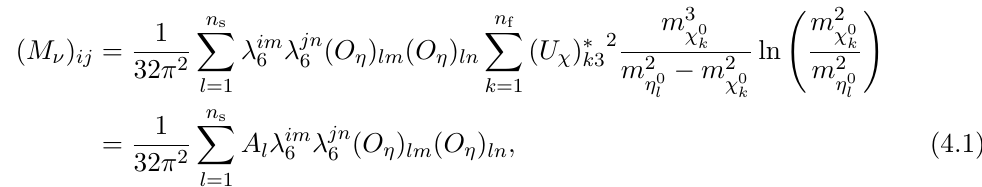
1 ; : : : ; n f , l 1 ; : : : ; n s ). The convention 2 f g 2 f g